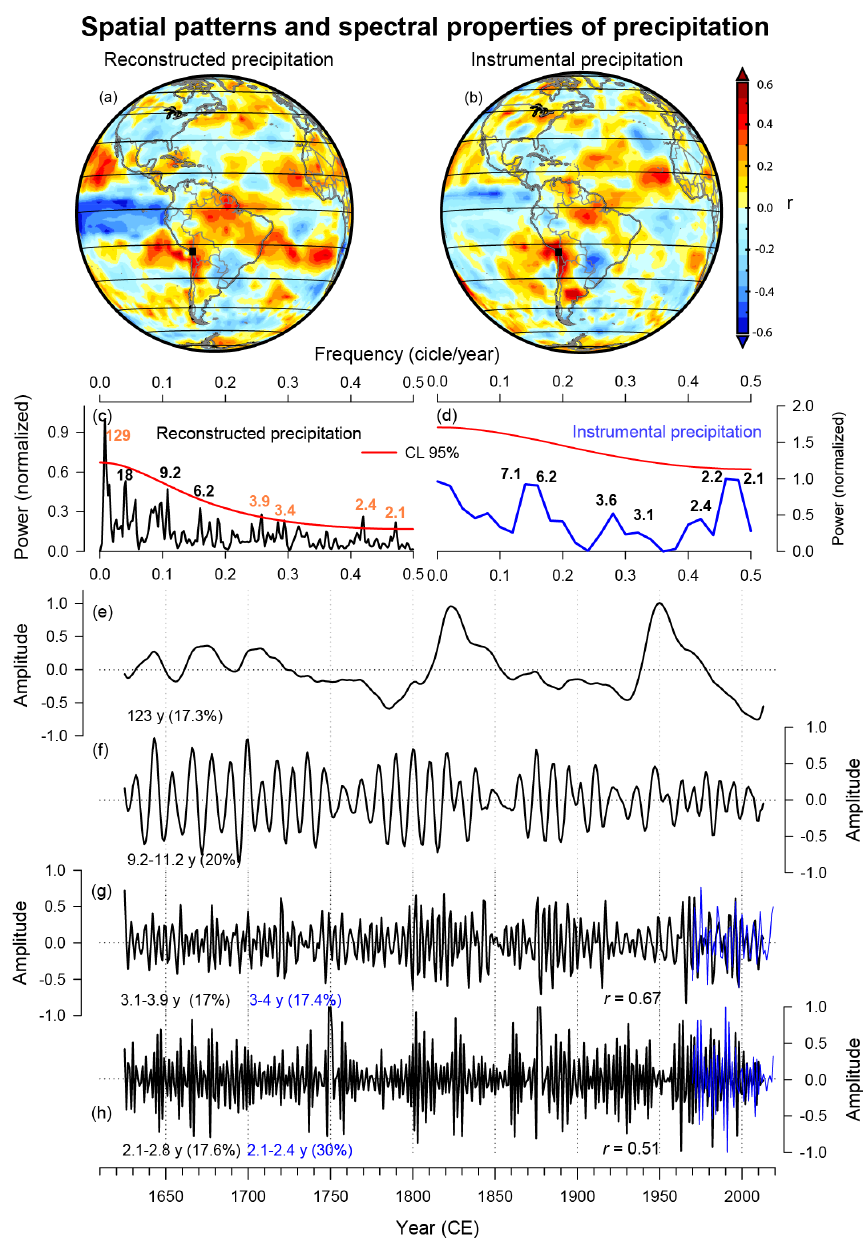
Figure 5. Spatial patterns and spectral properties of precipitation. Spatial correlation field between the GPCP 2 . 5 ◦ × 2 . 5 ◦ gridded NDJ precipitation and the northern Altiplano (a) reconstructed and (b) instrumental NDJ precipitation for the period 1979–2013. (c) Blackman– Tukey power spectral analysis of the reconstructed (1625–2013) and (d) instrumental (1970–2019) precipitation from the northern sector of the South American Altiplano. Black numbers indicate periods with high spectral power but not statistically significant (95% confidence level), while orange numbers represent significant peaks (95% confidence level). (e–h) Dominant modes of secular, decadal, and inter-annual variability extracted by singular spectral analysis (SSA) from the reconstructed and instrumental precipitation over the period 1625–2013 and 1970–2019, respectively. The frequencies of the SSA waveforms for the reconstructed (instrumental) precipitation are indicated in black (blue); number of years with the corresponding explained variance in percentages